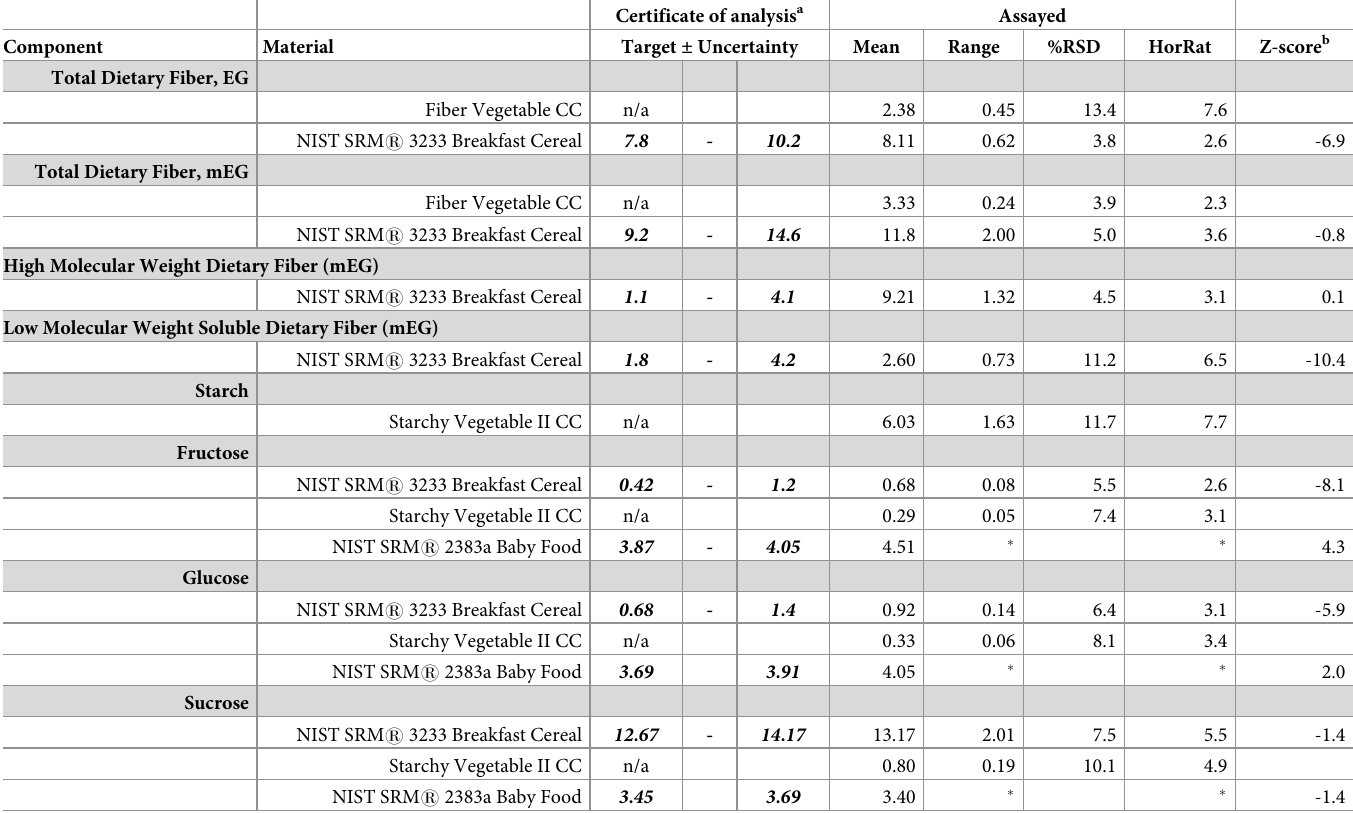
Table 1. Summary of results for commercial reference materials and control materials analyzed with samples from ripening study and retail study